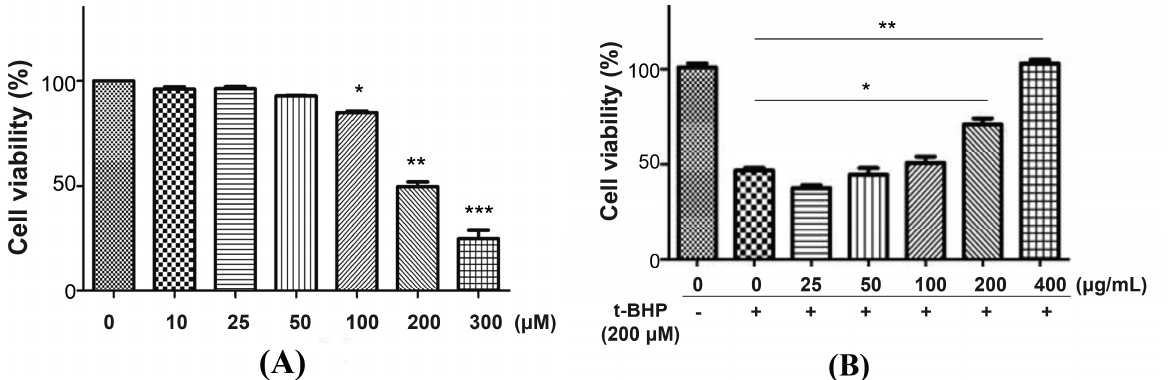
Figure 3. The protective effects of P. chinense extract on t -BHP-induced cytotoxicity in L02 cells. ( A ) L02 cells were treated with different concentrations of t -BHP for 6 h. * p < 0.05, ** p < 0.01 and *** p < 0.001 as compared to untreated control cells. ( B ) L02 cells were pretreated with different concentrations of P. chinense extract for 12 h, followed by treatment with 200 µM t -BHP for another 6 h. Cell viability was assessed by MTT assay. Data are expressed as means ± SEM of at least three independent experiments. Con indicates control. * p < 0.05 and ** p <